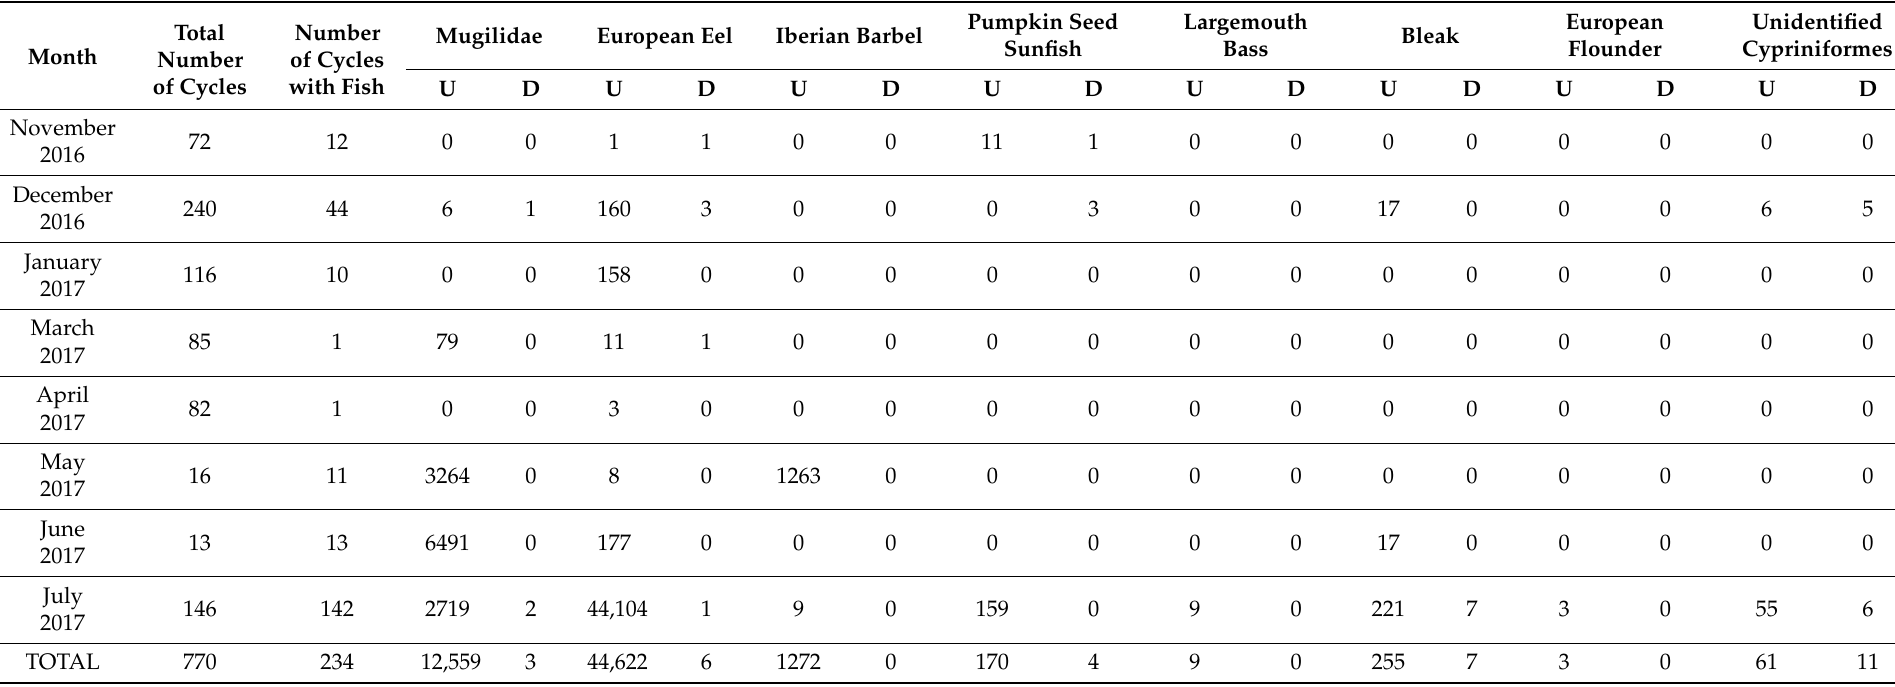
Table 3. Number of fish counted at the Crestuma-Lever fish lock between November 2016 and July 2017 (U—upstream,